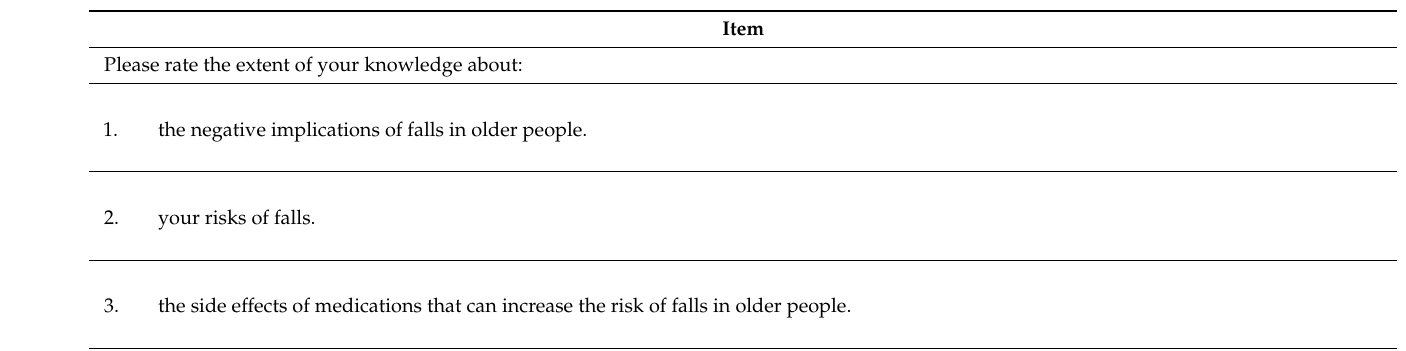
Table A1. Perceived-knowledge questionnaire a .